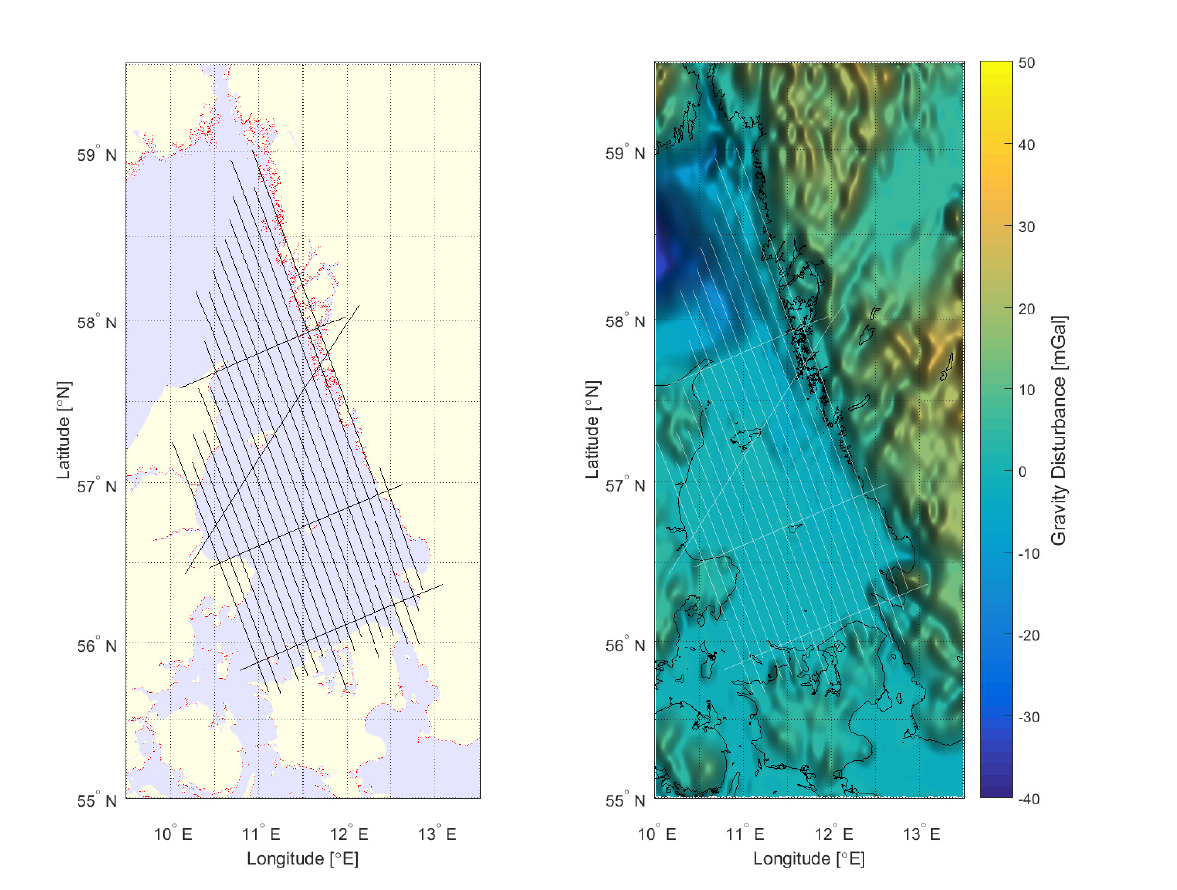
Figure A4. ( Left ) Mask plot indicating how the 3.75 arc-second DEM was constructed. The topography (white) originates from the 3 arc-second SRTM product [26], the bathymetry (blue) originates from the 3.75 arc-second EMODNet database and some areas in between (red) are interpolated. ( Right ) The computed gravitational response from topography/bathymetry at 1 km